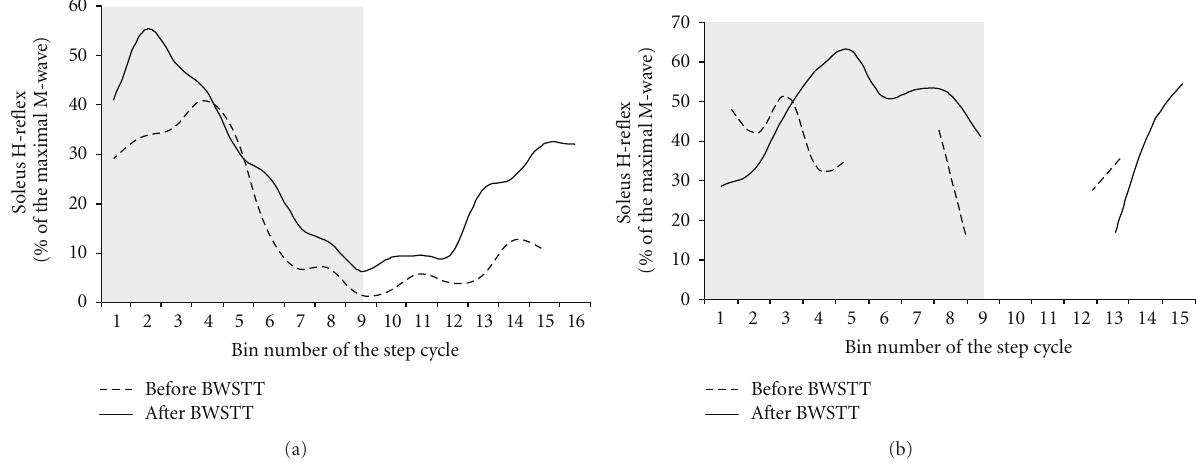
Figure 3: Soleus H-reflex modulation during assisted stepping before and after locomotor training in SCI. The unconditioned soleus H- reflex modulation before (dashed lines) and after (solid lines) 60 sessions of body weight-supported treadmill training (BWSTT) (a) and the conditioned soleus H-reflex by subthreshold TMS at the conditioning-test interval of 1 ms (b) are indicated as a function of the step cycle. The mean amplitude of the unconditioned and conditioned soleus H-reflexes evoked at each bin is expressed as a percentage of the maximal M-wave evoked 80ms after the test H-reflex. TMS was delivered at 0.95 times MEP threshold for the soleus muscle at a conditioning-test interval of 1-ms. Unconditioned and conditioned soleus H-reflexes were accepted when the associated M-waves ranged from 4 to 8% of the maximal M-wave evoked at each bin. H-reflex values are not indicated for some of the bins after BWSTT because they were not accepted based on the M-wave amplitude as a percentage of the maximal M-wave, which is di ff erent from not being evocable as was the case for before BWSTT. The step cycle was divided into 16 equal time windows or bins. Stance phase duration is identified by the grey region. Bin 1 corresponds to heel strike. Bins 8, 9, and 16 correspond approximately to stance-to-swing transition, swing phase initiation, and swing-to- stance transition,